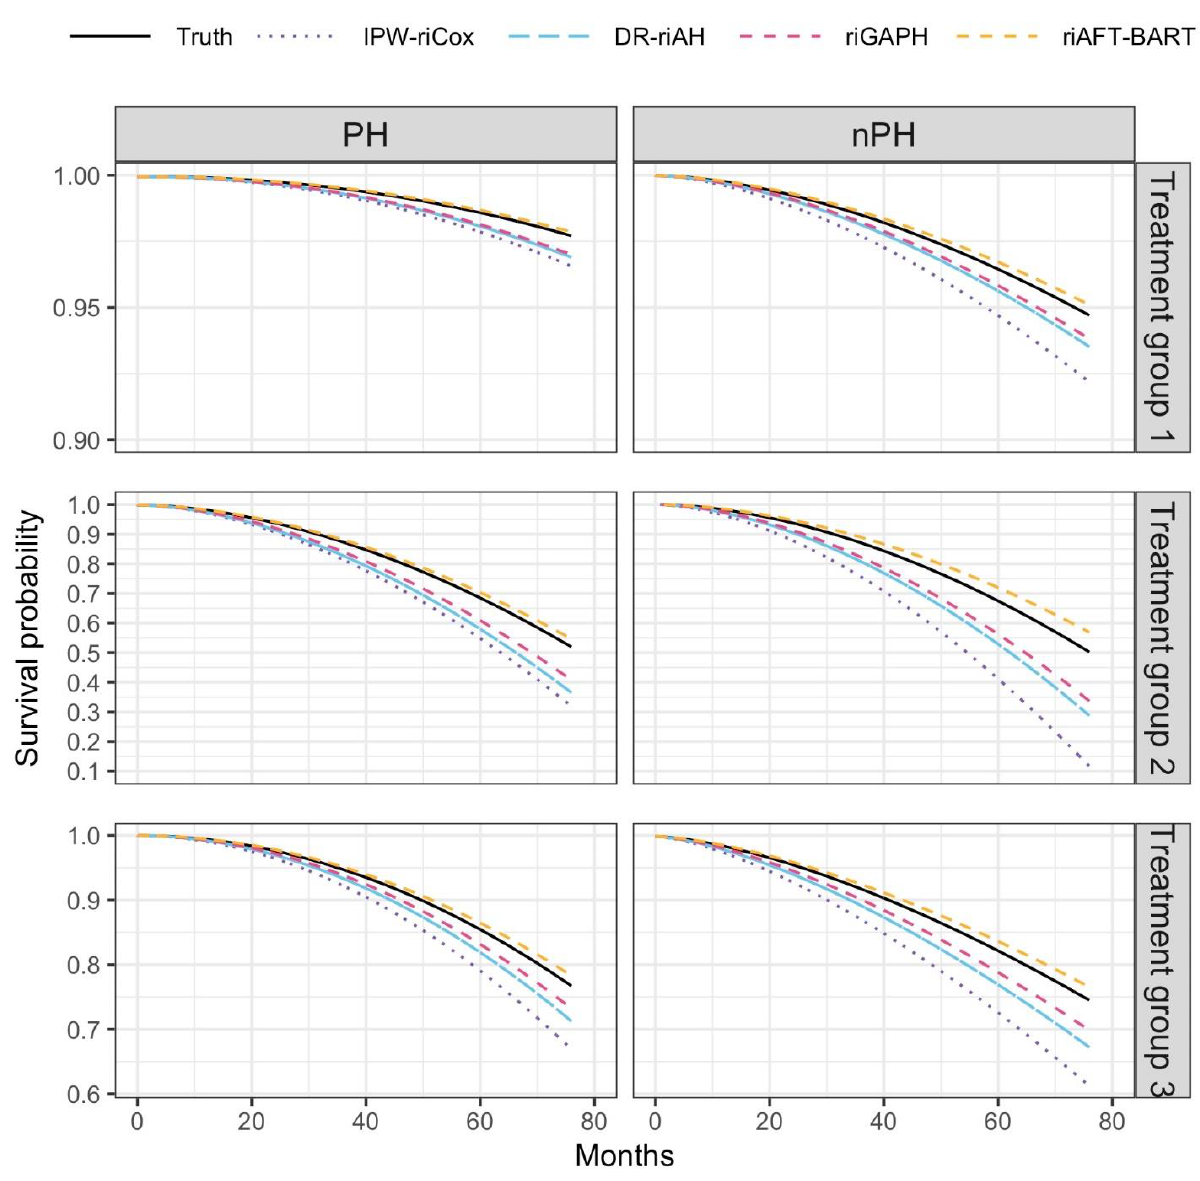
Figure 1. The Kaplan–Meier survival curves for three treatment groups in our simulation, and the mean counterfactual survival curves estimated by the four methods IPW-riCox, DR-riAH, riGAPH and riAFT-BART, under proportional hazards and nonproportional hazards. Table 1. Mean (and standard deviation) precision in the estimation of heterogeneous effects (PEHE) for each of the four methods based on 5-year survival probability. The proposed method riAFT-BART delivered the highest accuracy in estimating the treatment effect heterogeneity, indicated by the smallest PEHE values across all simulation